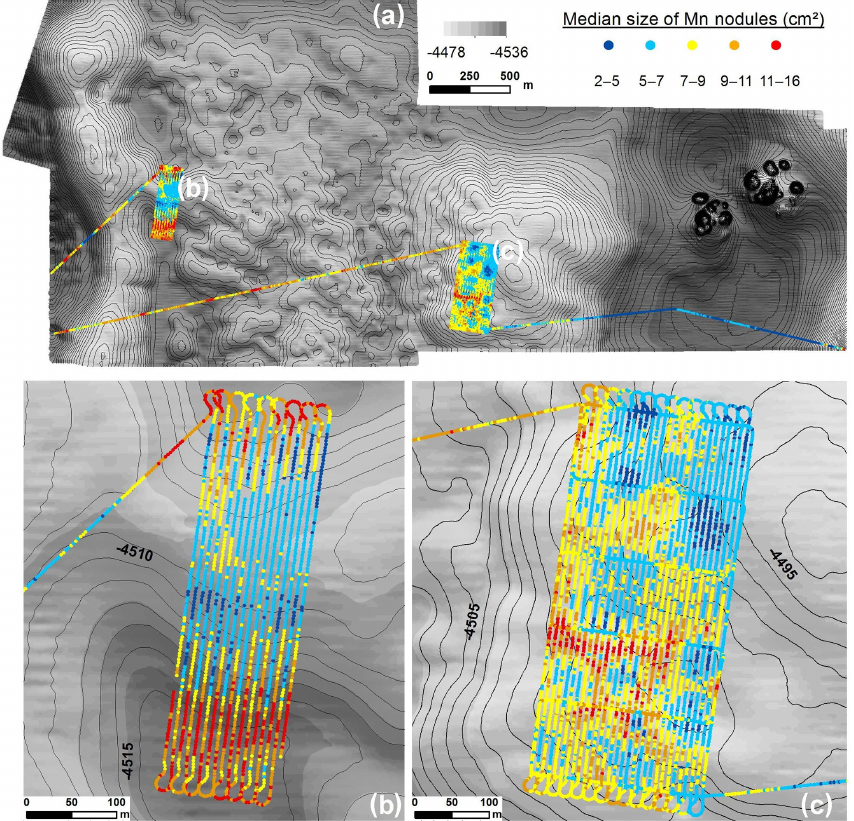
Figure 9. (a) The spatial distribution of median Mn-nodule size (in cm 2 ). (b) The estimation of median Mn-nodule size in subarea b and mainly in its southern part has been probably affected by the nonconstant altitude of the AUV. (c) The distribution of the median size inside subarea c shows also a clumped